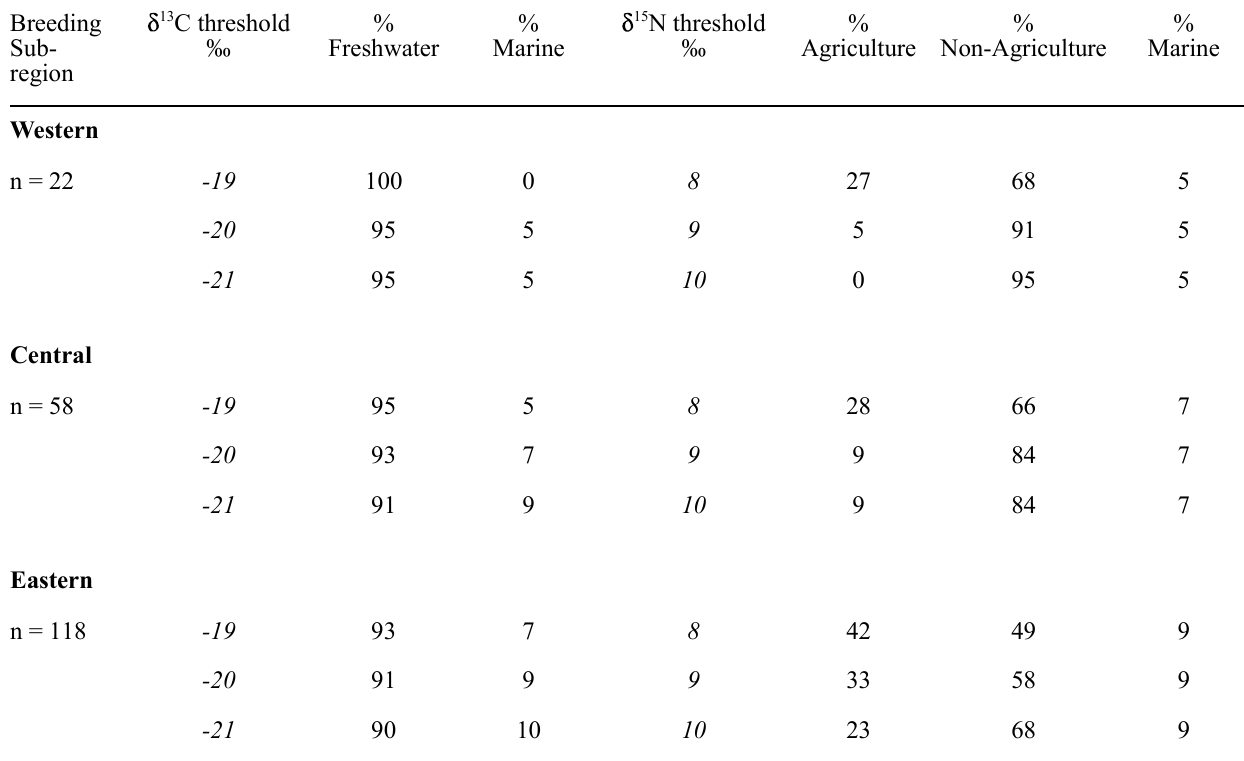
Table 1 . Sensitivity of American black duck feather samples to assignment to freshwater and marine habitats, and agricultural and non-agricultural landscapes based 13C on and 15N thresholds, respectively. 13 C threshold 15 N threshold Breeding % % % % % Sub- ‰ Freshwater Marine ‰ Agriculture Non-Agriculture Marine region Western n = 22